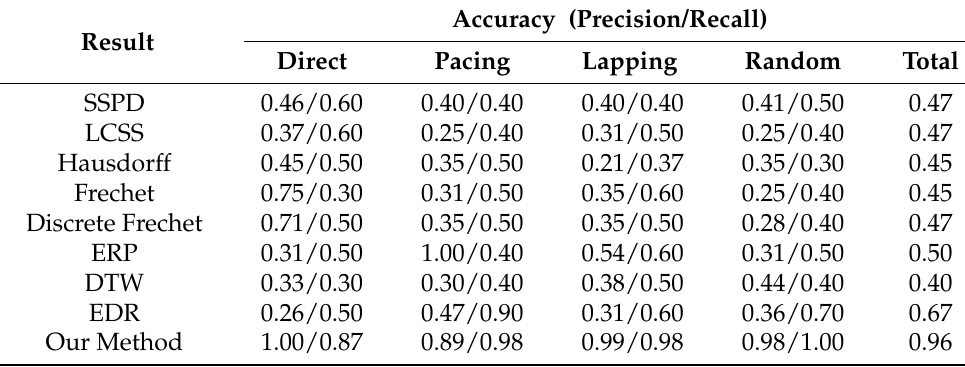
Table 1. Clustering performance on the simulated dataset.